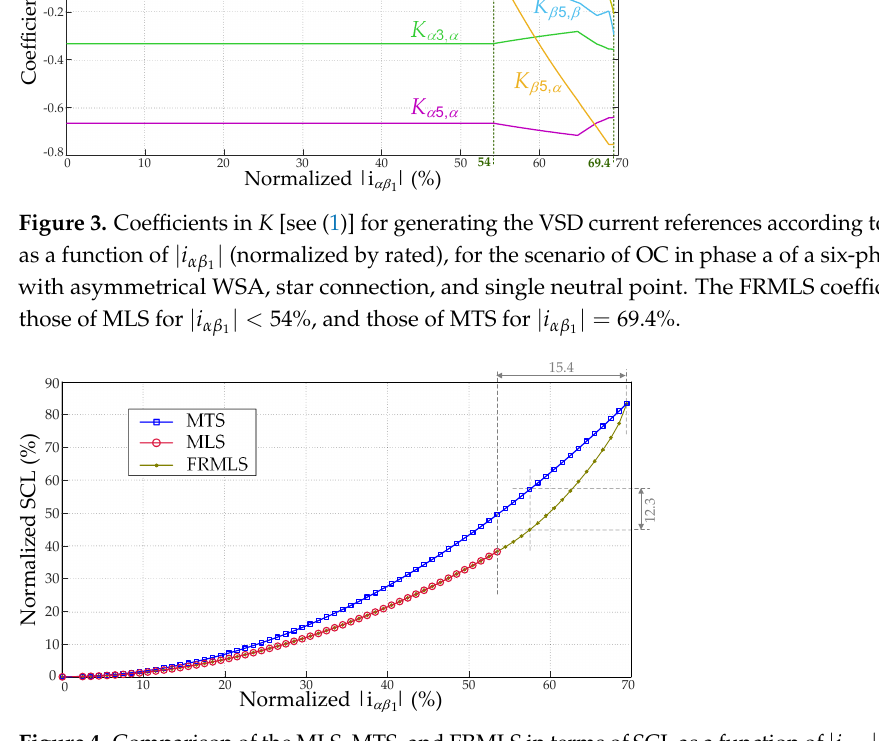
Figure 4. Comparison of the MLS, MTS, and FRMLS in terms of SCL as a function of | i αβ by rated), for the scenario of OC in one phase of a six-phase machine with asymmetrical WSA, star connection, and single neutral